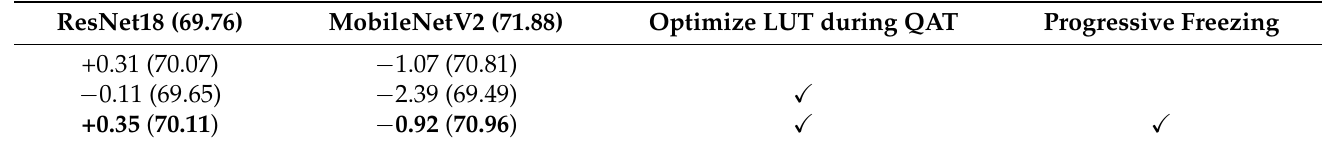
Table 5. Study on the added value to the Top-1 accuracy of optimizing the LUT values during QAT and the effect of progressive freezing. Experiments were conducted with 4 bit weights and 8 bit